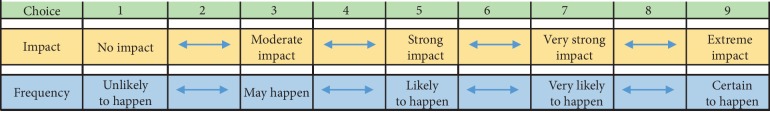
Scale definition for the importance and frequency levels for each hazard.